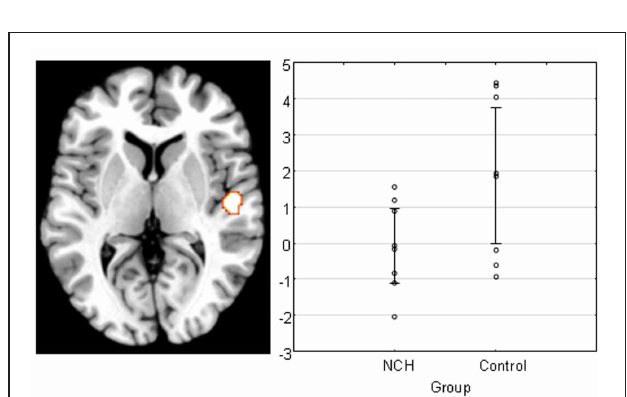
purposes. Line graphs on the left side show changes in parameter estimates (arbitrary units) in the left and right PAC (peak voxel) to change in interaural intensity difference (IID) and attention (FR, forced-right; FL, forced-left), pooled across groups. Vertical lines represent 95% confidence intervals.